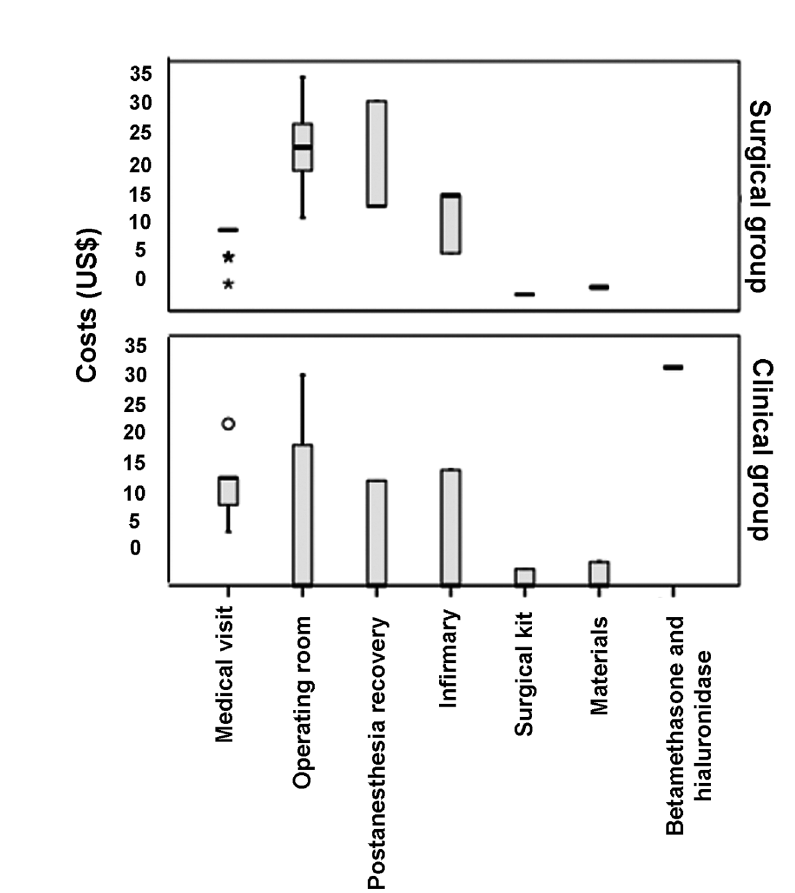
Figure 2 – Box plot of the cost analysis of the parameters investigated in both